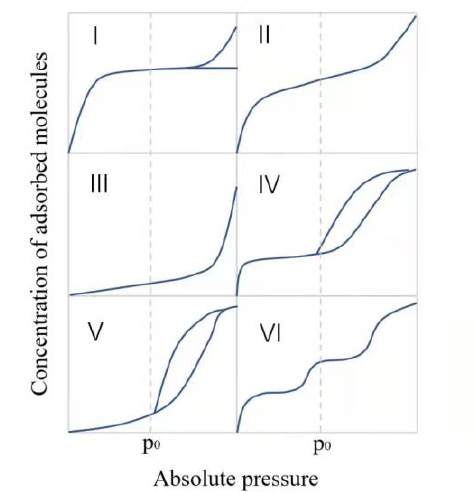
Fig. 9. Types of adsorption-desorption isotherms according to IUPAC and BDDT